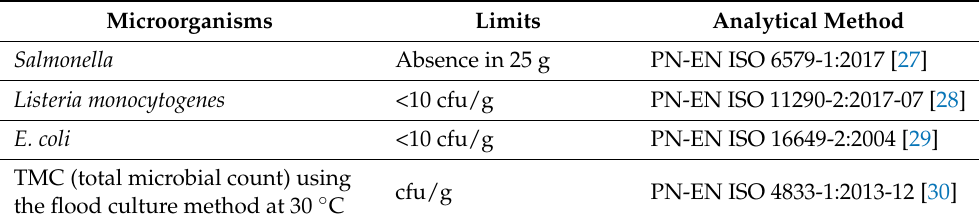
Table 2. Type, scope, and methods of conducted microbiological analyses. Microorganisms Limits Analytical Method Salmonella